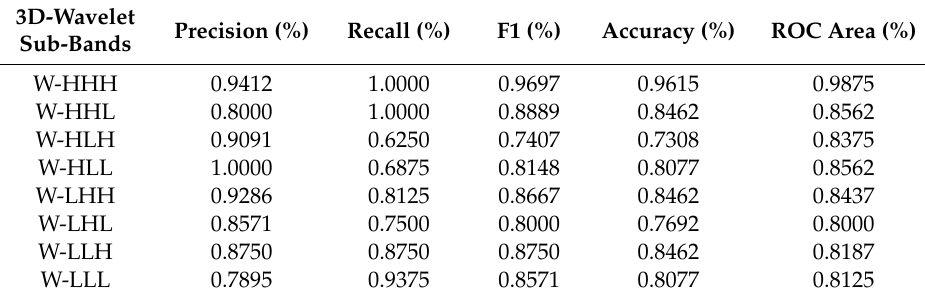
Table 5. Classification performance of Wavelet Filters.